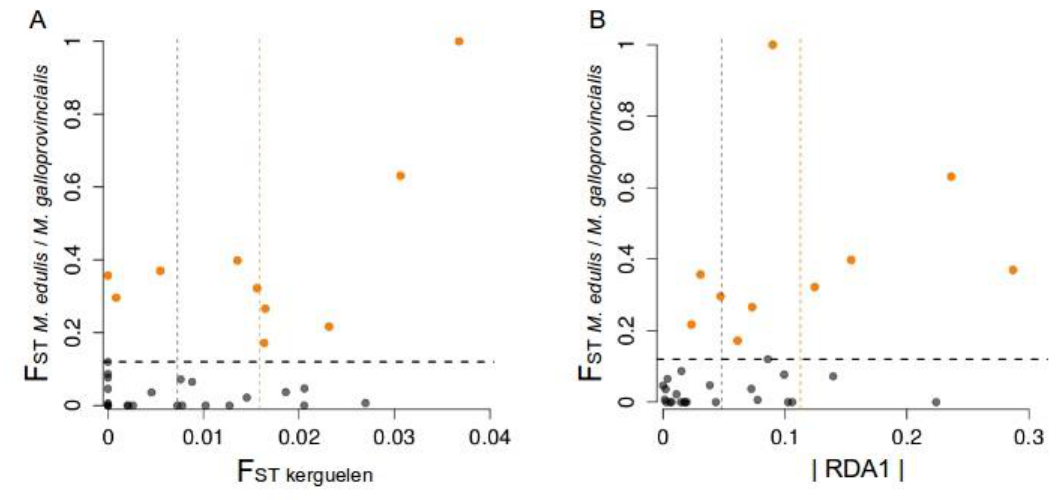
Figure 6 . Correlation between the level of differentiation among the Kerguelen Islands (x-axis) and the Northern species (F ST , y-axis) at each KASPar SNP. Panel ( A ) shows the genetic differentiation between Kerguelen populations (global F ST ); and panel ( B ) shows the genetic-by-environment association (locus coordinates on the first axis of the conditioned RDA (absolute values), see Table S11). Northern species are Mytilus edulis (EU – peripheral, European population of the North Sea) and Mytilus galloprovincialis (MED - west, Mediterranean population of the West basin). Ancestry-informative loci, i.e., F ST M.edulis_M.galloprovincialis > 0.120 (horizontal dashed line, see Table S2), are depicted in ora nge. Wilcoxon’s test between the ancestry-informative loci (orange) and the background loci (grey): ( A ) mean_orange=0.015, mean_grey=0.007 (p-value=0.021); ( B ) mean_orange=0.112, mean_grey=0.048 (p-value=0.006). Their respective means are depicted by vertical dashed lines. Pearson correlation coefficient: ( A ) r=0.540 (p- value=0.001); ( B ) r=0.439